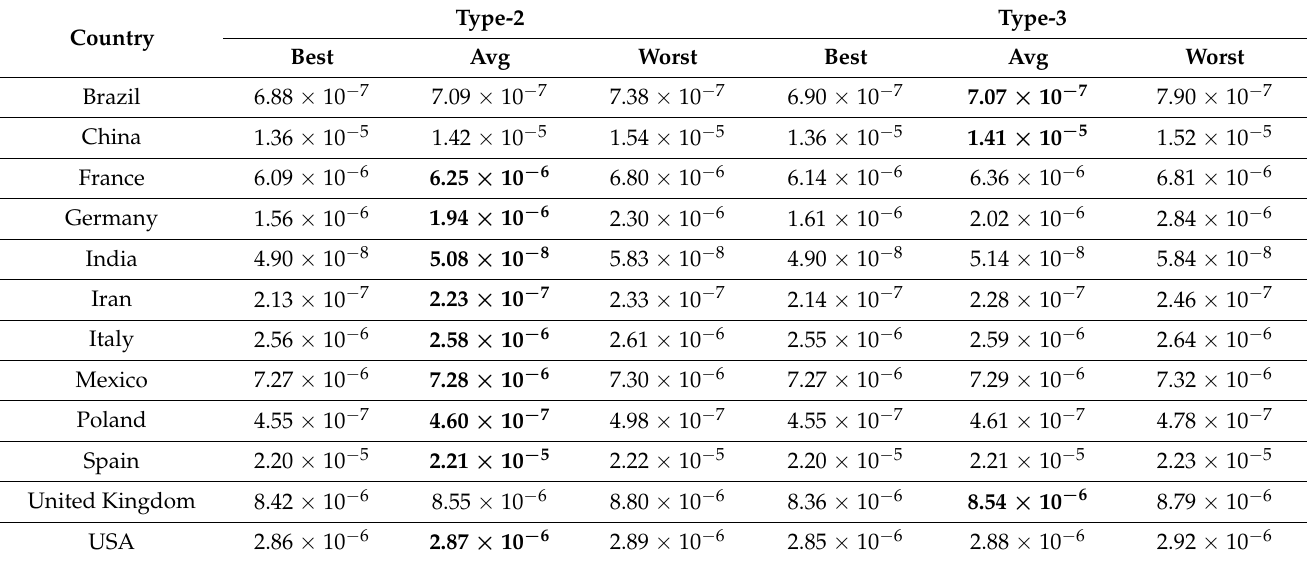
Table 12. First data period (testing